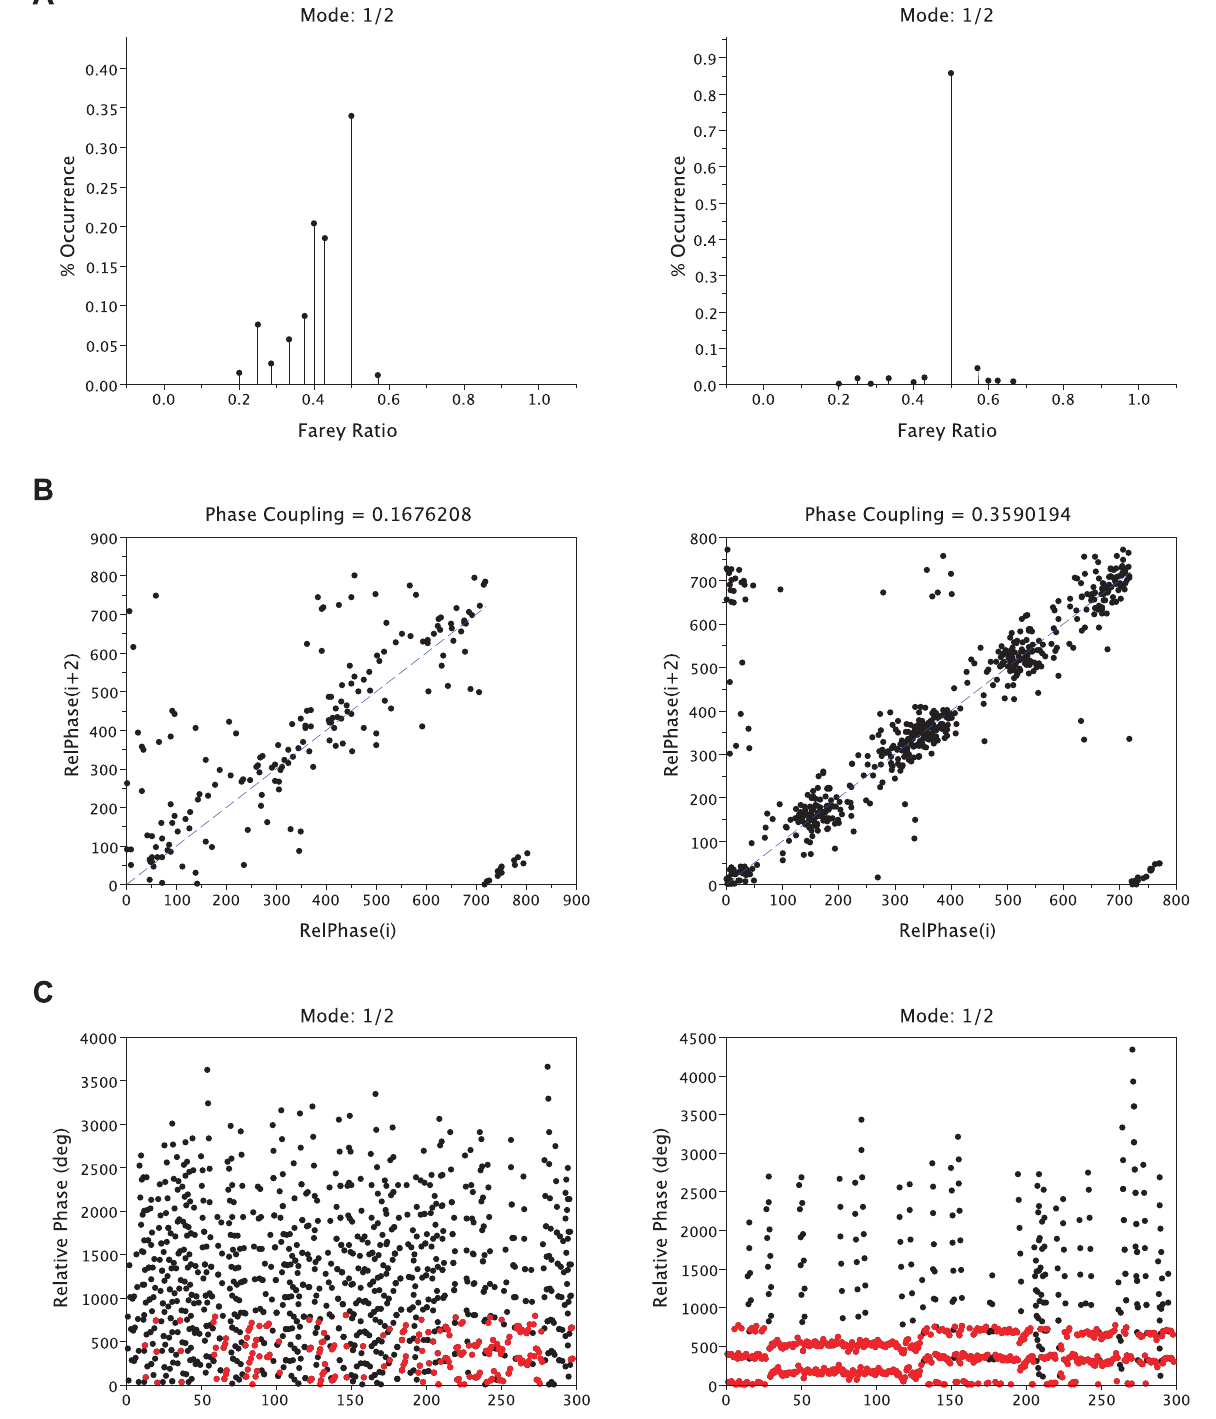
Figure 4. LRC variables for two representative participants in the FREE session. The left three panels correspond to S05 and the right three panels correspond to S15. The first two panels (A. Frequency Ratios Distribution) represent the distribution of the frequency ratios. The next two panels (B. Return Maps) represent the dispersion of the relative phase in the return map. The last two panels (C. Relative Phases) represent the relative phase values during five consecutive minutes where red dots represent the relative phase values for the modal frequency ratio and black dots represent the relative phase values for the other expressed frequency ratios.